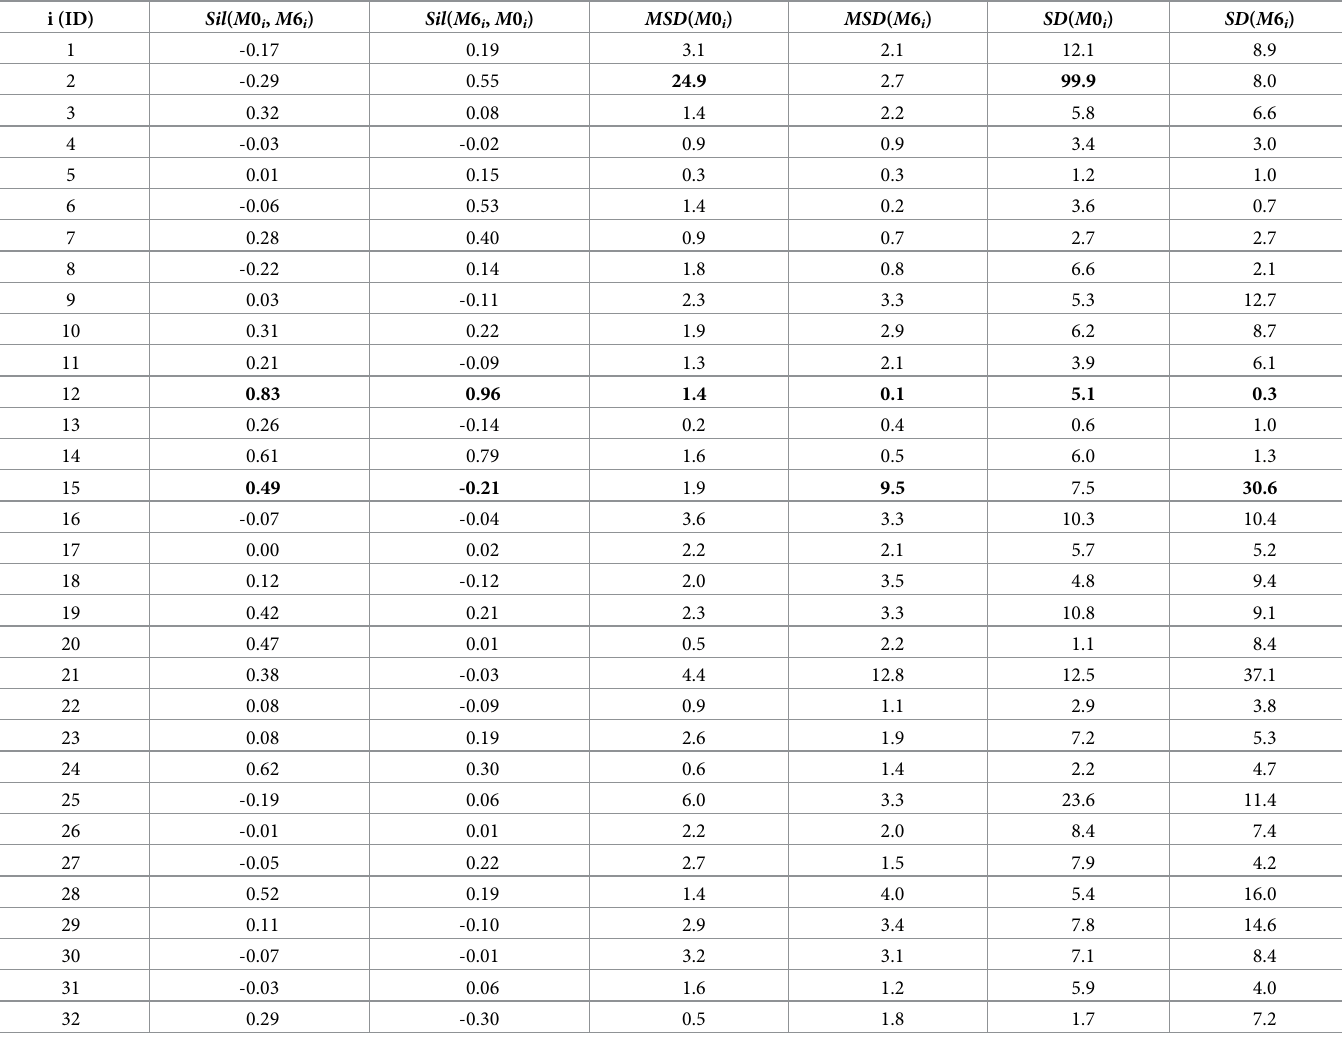
Table 4. Individual silhouette score, mean squared distance and squared diameter for each